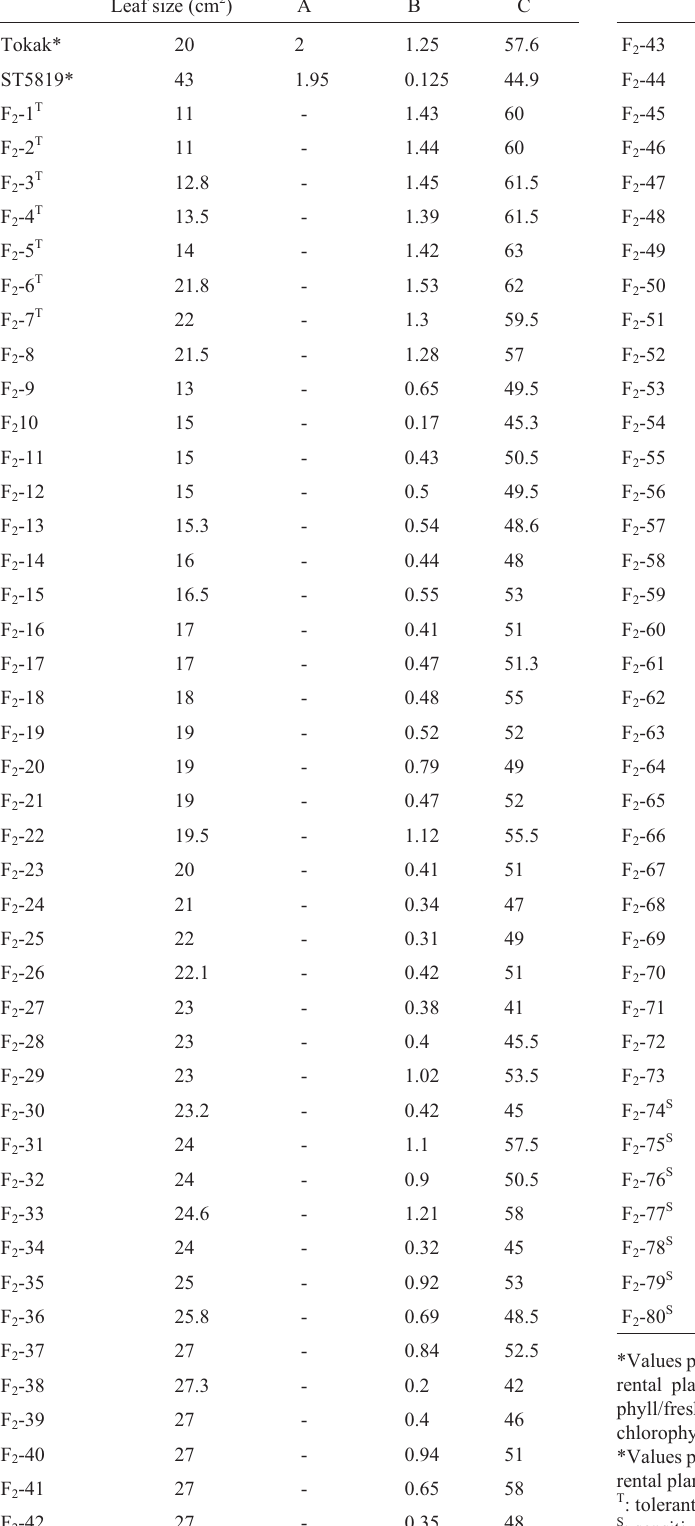
Table 2 - Morphological and physiological data of parental lines* and their F 2 individuals, used to make up the water-stress tolerant and sensitive barley